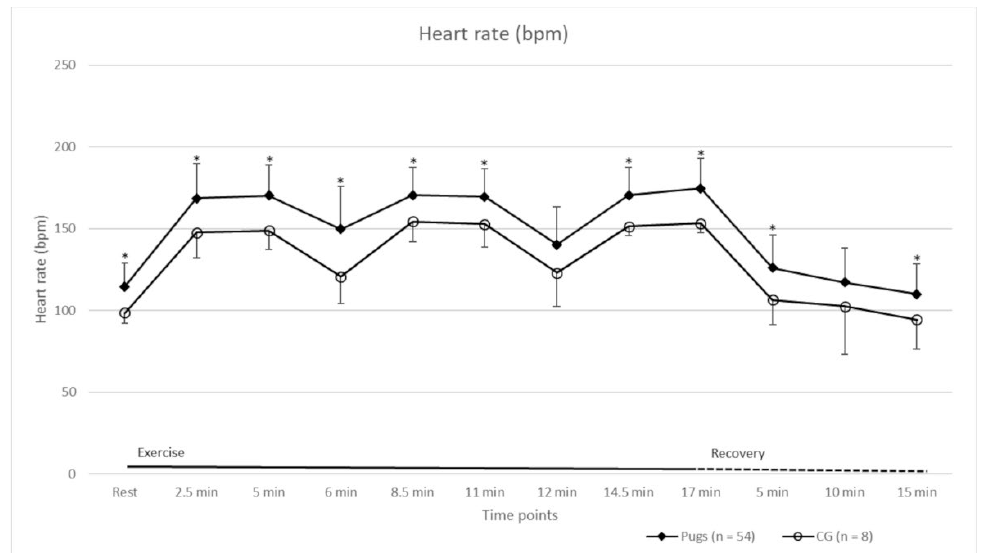
Figure 1. Mean heart rate (beats per minute, bpm) (± standard deviation) of pugs ( n = 54) and control group (CG) ( n = 8) at rest, during exercise, and throughout recovery period. Statistically significant differences between the groups at the measurement time points are indicated by an asterisk (*).